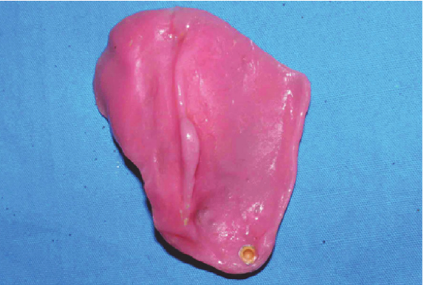
Figure 9: Retentive component incorporated in obturator